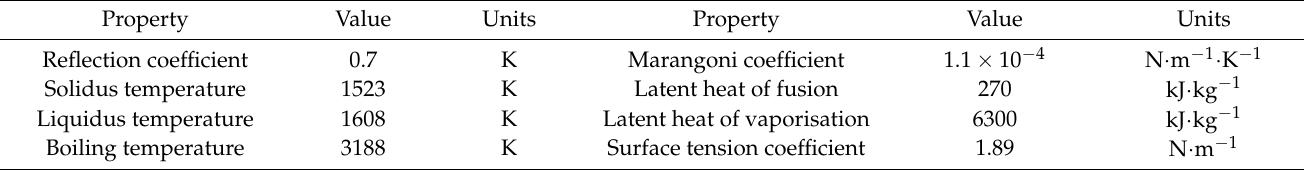
Figure 5. Temperature-dependent thermophysical properties of IN718. ( a ) Density; ( b ) Conductiv- ity; ( c ) Specific Heat; ( d ) Viscosity. Reprinted with permission from [31]. Copyright 2016 Elsevier. Table 3. IN718 material properties. Data from Table 3. In718 material properties. Data from [30].